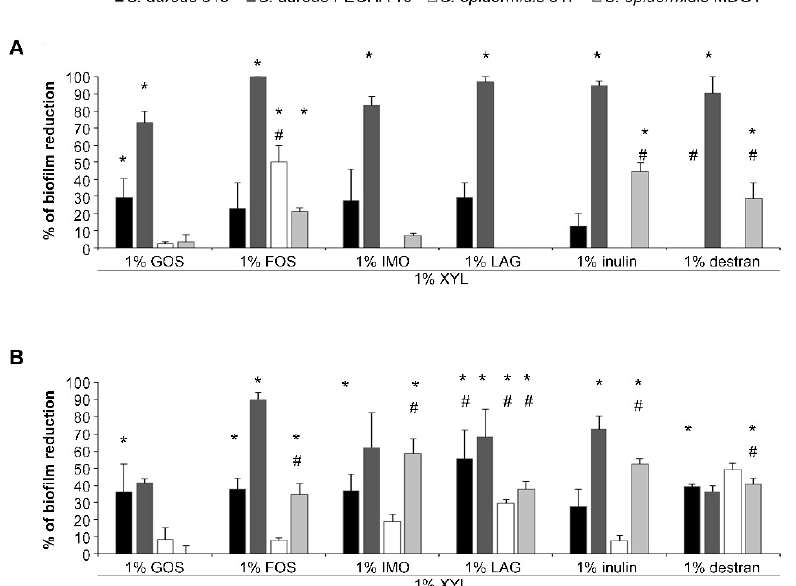
Figure 3. Percentage of reduction S. aureus 815, S. aureus PECHA 10, S. epidermidis 317 and S. epidermidis MDG1 adhesion and biofilm formation after treatment with 1% XYL and 1% FOS or IMO or LAG or inulin or dextran at 3 ( A ) and 24 h ( B ), respectively. 1% XYL and 1% GOS is the reference control (RC). For abbreviations, see materials and methods. * statistically significant with respect to the control. # statistically significant with respect to RC.